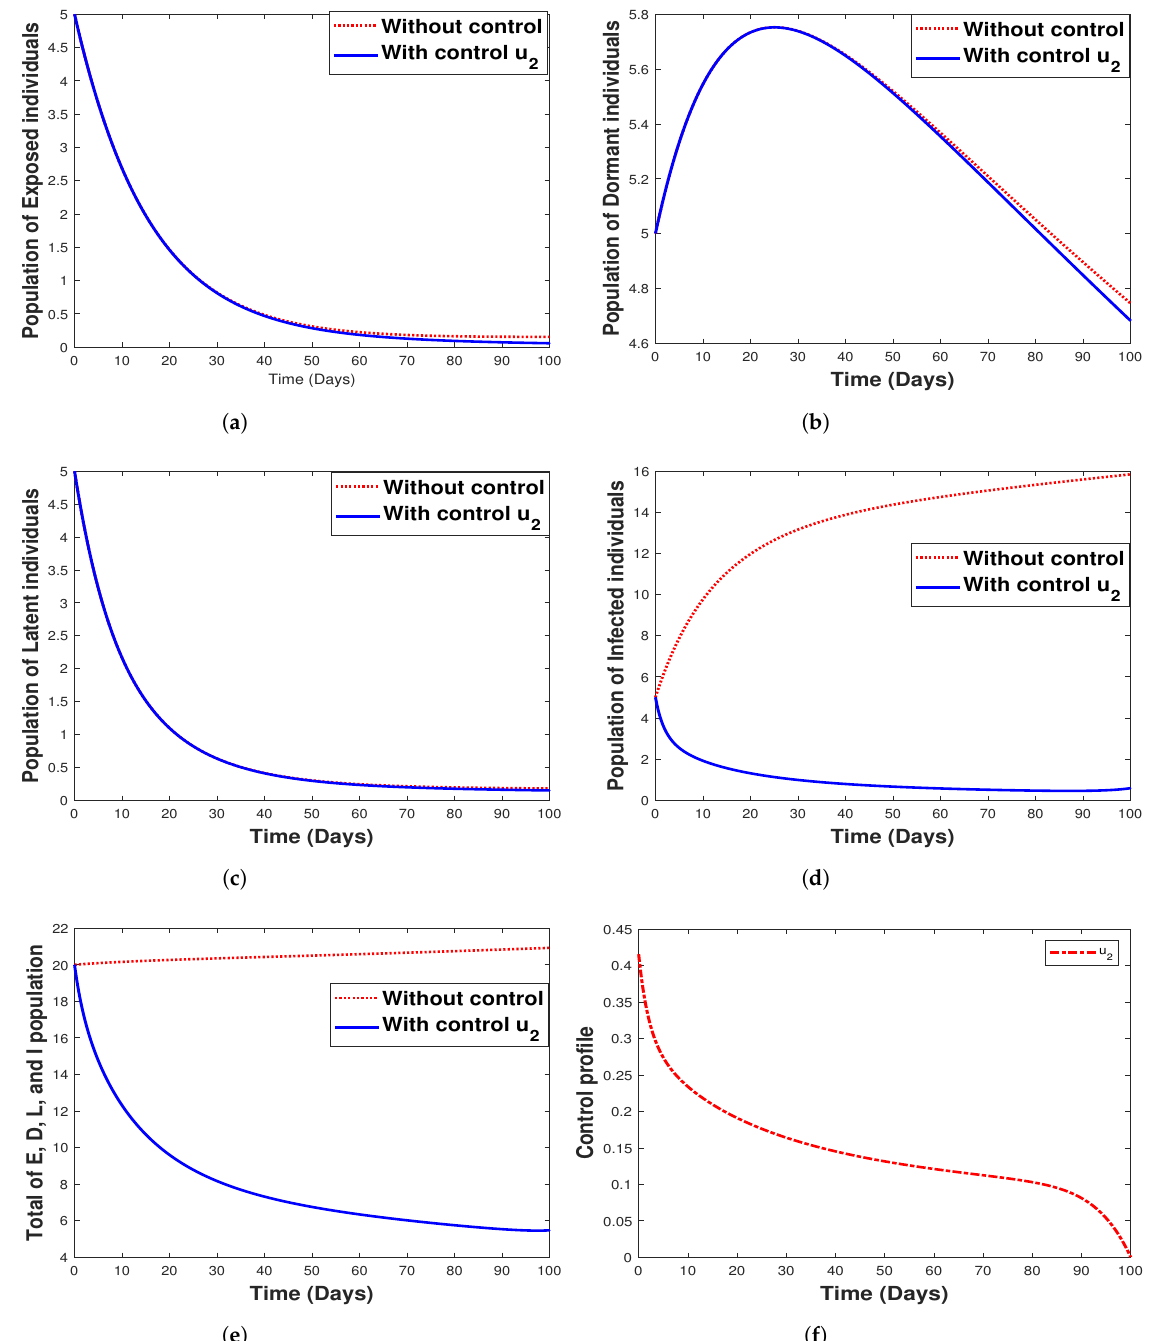
Figure 13. Simulation results for strategy 2 shows the dynamics of exposed compartment, dormant compartment, latent compartment, infected compartment, total of exposed, dormant, latent, and infected population, and the dynamic of control u 2 for subfigure ( a )–( f ), respectively.